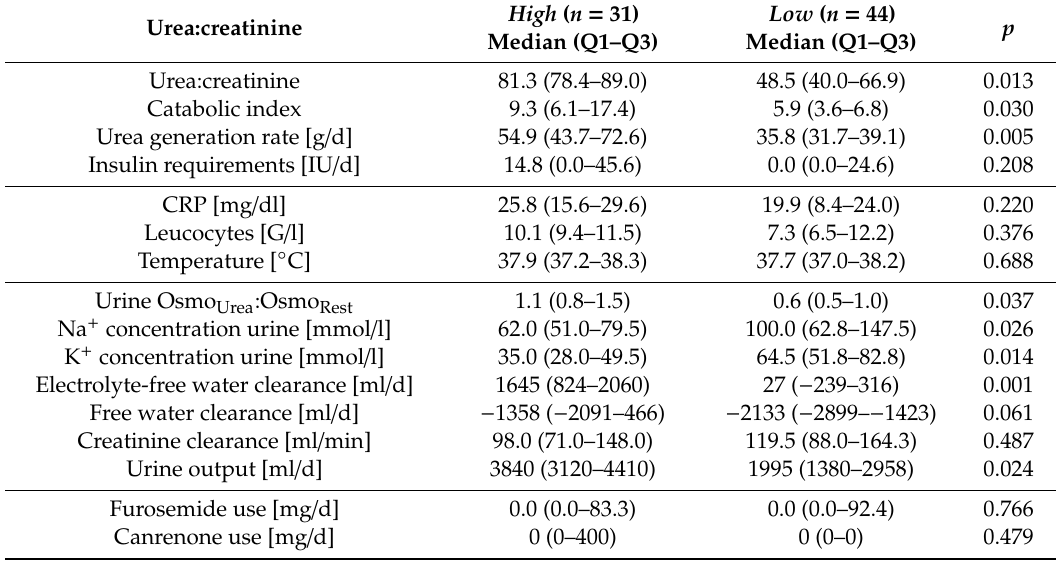
Table 2. Group characteristics during serum sodium (NaS) incline. ( n indicating total days of NaS-incline).